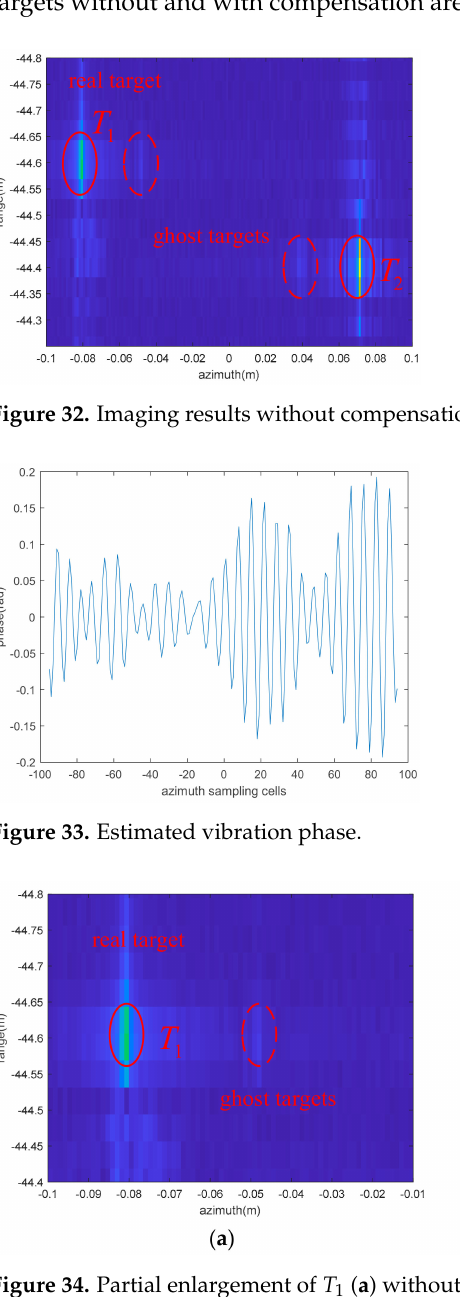
Figure 34. Partial enlargement of T 1 ( a ) without compensation and ( b ) with